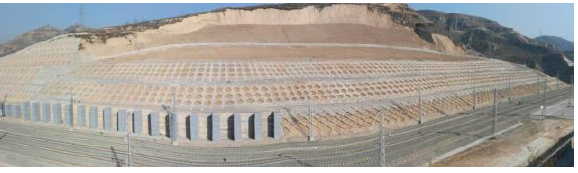
Figure 4. Experiment area